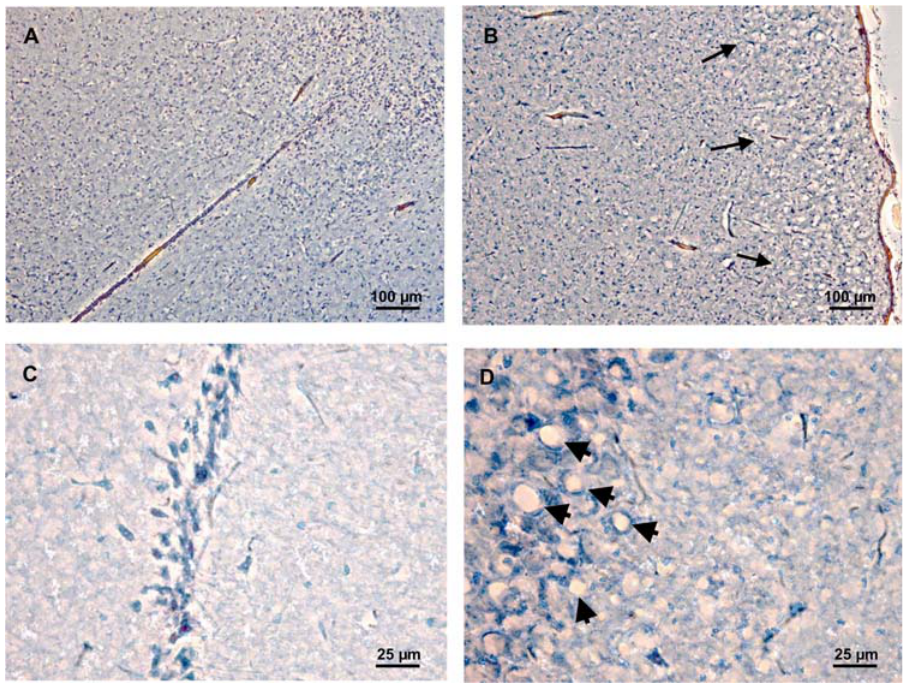
Figure 5. Histochemistry of coronal sections from brain of hamsters treated with solid MBM residue. Coronal brain sections were stained with Hematoxylin-Congo red. (A, B) Control animals inoculated with the solid MBM residue resulting from the reaction with MBM + 5% uninfected brain exhibited normal brain morphology without vacuolation or amyloidosis. (C, D) Cryo-sections of hamster brain stained with Hematoxylin-Congo red show vacuolation (arrows) when animals were inoculated with the Solid MBM residue resulting from the reaction with MBM + 5% infected brain suggesting scrapie infection. Both animals were sacrificed 150 days post-inoculation, when the infected animal displayed severe scrapie